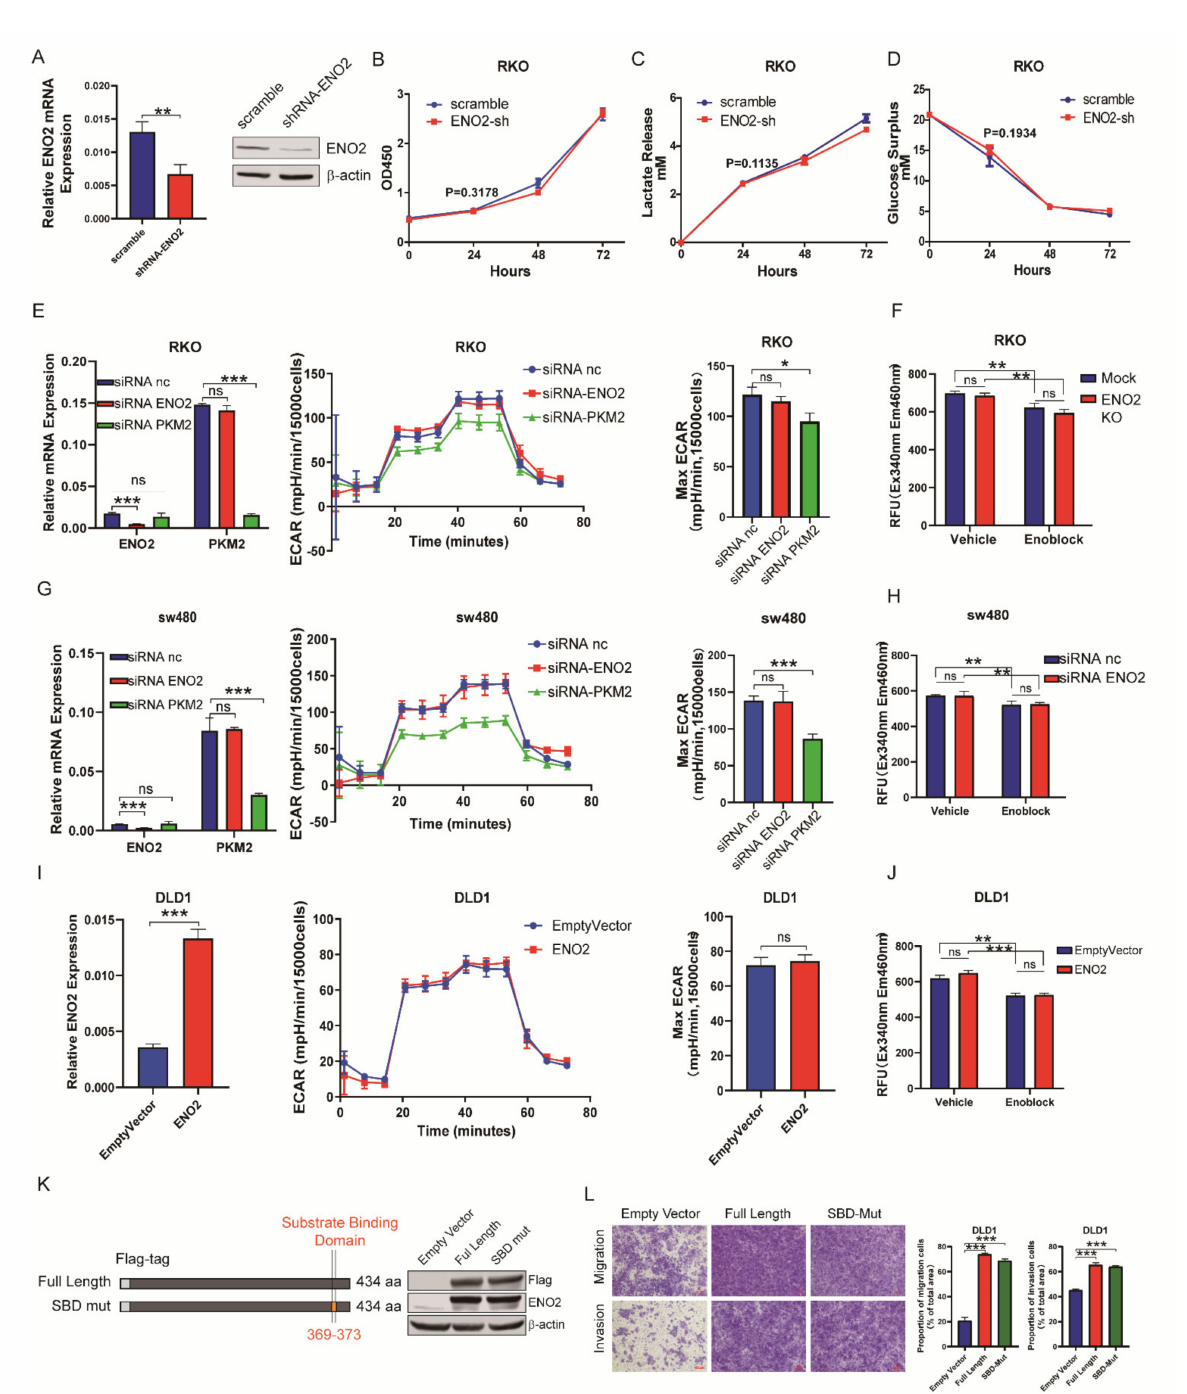
Figure 3. ENO2 promoted metastasis independently of altering the glycolytic rate in CRC. ( A ): qPCR and Western blot analysis confirmed ENO2 knockdown in RKO cells. ( B – D ): ENO2 knockdown did not significantly inhibit cell proliferation, glucose consumption or lactate production in RKO cells. ( E ): The ECAR of the indicated cells was detected by using a Seahorse XFe96 Extracellular Flux Analyzer, and the maximum glycolytic rates are summarized. PKM2 was knocked down as a positive control. n = 3 per group. ( F ): The total enolase activity of RKO ENO2 knockdown cells was detected by performing a relative fluorescence unit (RFU) assay. Enoblock was used as a positive control. ( G – J ): Seahorse and total enolase activity of SW480 ENO2 knockdown cells and DLD1 ENO2 overexpressing cells. ( K ): Characterization of ENO2 with mutations in the substrate binding region. ( L ): Mutations in the substrate binding region of ENO2 did not suppress its metastatic effect. Data are shown as the mean ± SD. * p < 0.05, ** p < 0.01, *** p < 0.001. ns: non